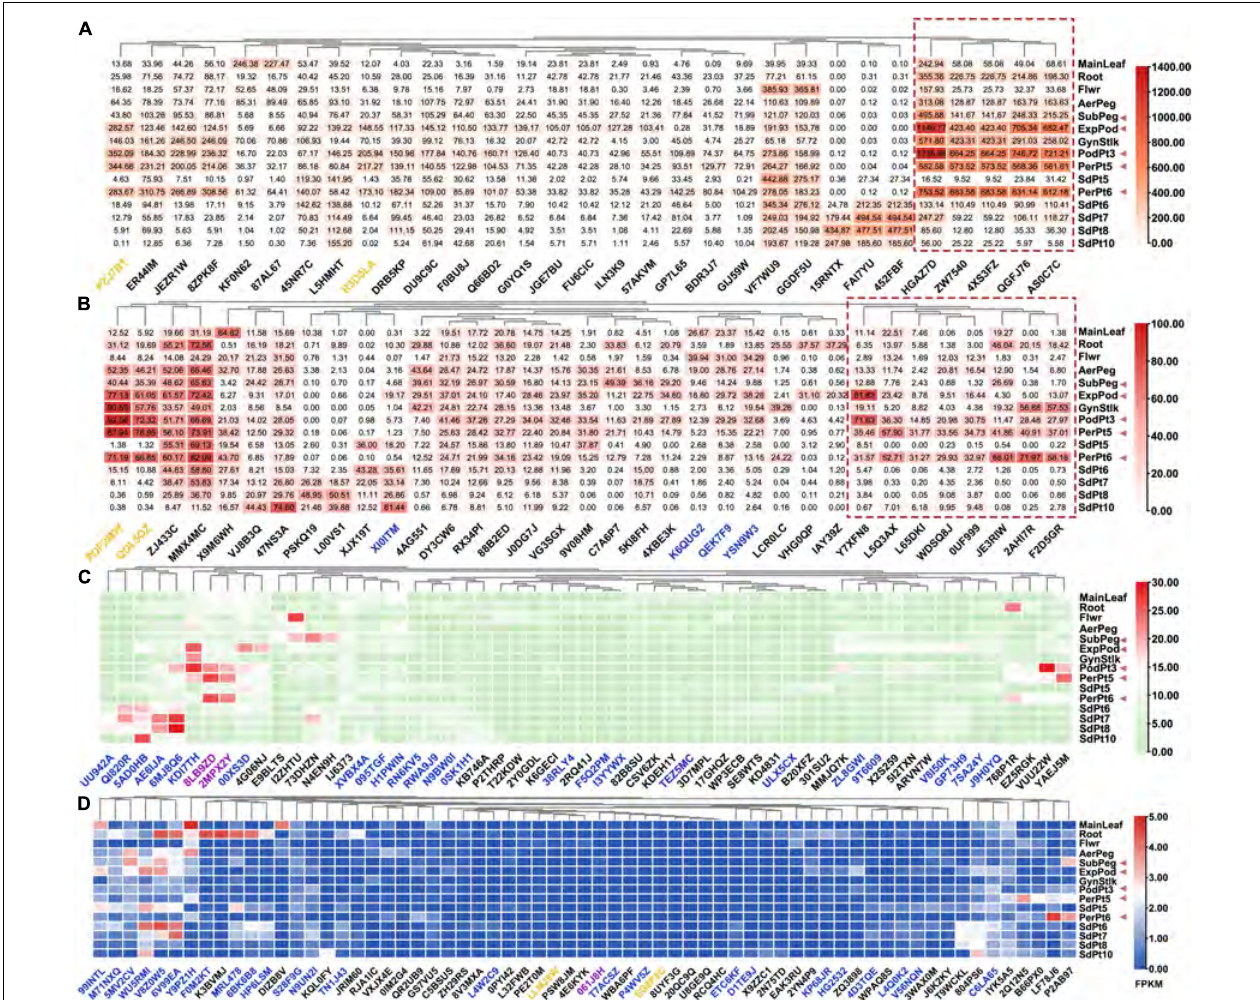
FIGURE 6 | Gene express patterns of 188 FcAP2/ERF genes in 15 samples in A. hypogaea cv. Tifrunner. Main leaf, main stem leaf; Root, roots of 10 days postemergence; Flwr, petals, keel, and hypanthium sepals; AerPeg, elongating aerial pegs; Subpeg, elongating subterranean pegs; GynStlk, Pattee 1 stalk of gynophore; PodPt3, Pattee 3 pod; PerPt5, Pattee 5 pericarp; SdPt5, Pattee 5 seed; PerPt6, Pattee 6 pericarp; SdPt6, Pattee 6 seed; SdPt7, Pattee 7 seed; SdPt8, Pattee 8 seed; SdPt10, Pattee 10 seed (Clevenger et al., 2016). Black gene ID: ERFs; blue gene ID: AP2; yellow gene ID: RAV; purple gene ID: Soloist. They were divided into the four groups, red dotted boxes indicated FcAP2/ERF s that might be involved in mechanical pressure signal transduction. The red triangle indicates the tissues that experience mechanical stress. (A) The maximum FPKM value was greater than 100; (B) The maximum FPKM value was between 30 and 100; (C) The maximum FPKM value was between 5 and 30; (D) The maximum FPKM value was less than